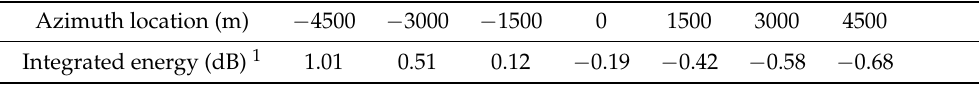
Table 2. Imaging results for targets at swath edge, calibrated with the reference EAP.